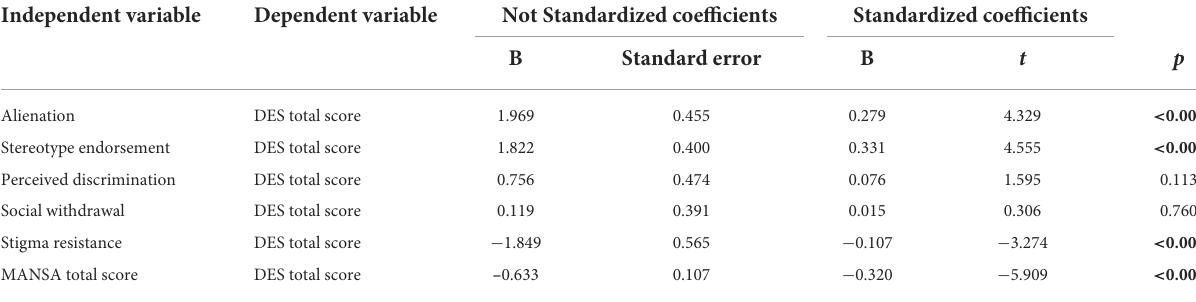
TABLE 5 Results of linear